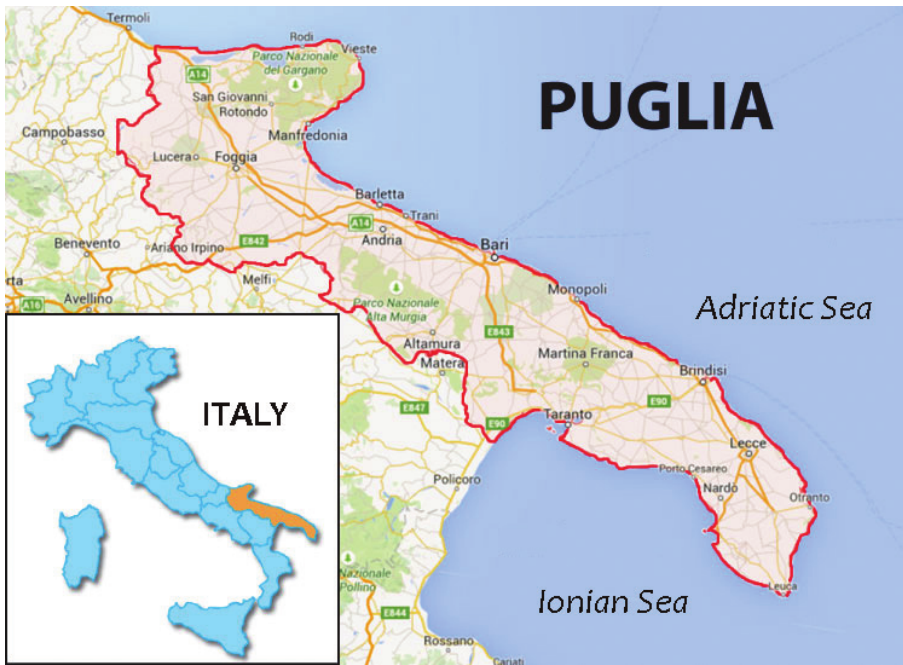
Figure 1. Study area: Apulia region (Southern